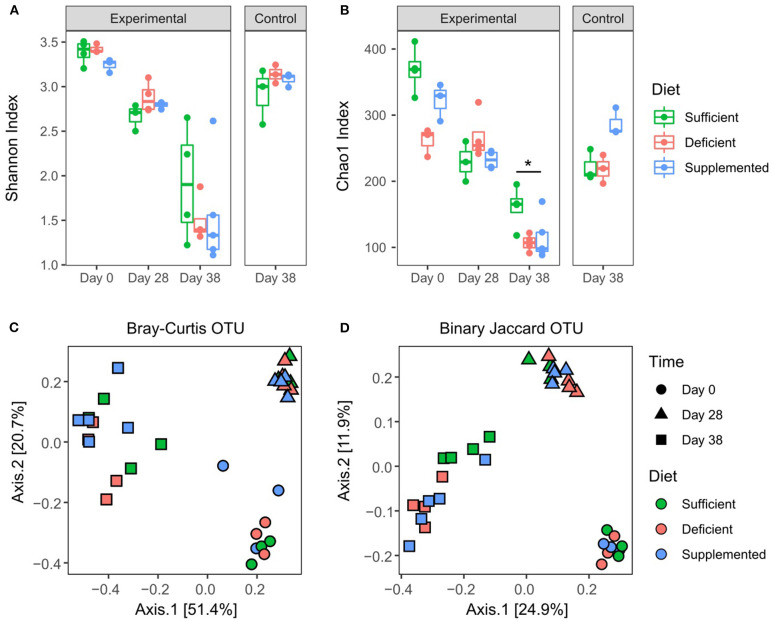
Effects of varying levels of dietary vitamin B12 on fecal microbial diversity and composition. Alpha diversity: Shannon index (A), OTU table rarefied 12,000. No significant differences between dietary groups post 4 weeks of intervention, or post DSS treatment. Chao1 index (B). Significant effects were found for both B12 diet (F2, 24 = 5.79, P = 0.009) and diet and time interaction (F4, 24 = 5.5, P = 0.002), Two-way ANOVA followed by Tukey's post-hoc test. Beta diversity: Binary Jaccard (C) and Bray-Curtis (D) were analyzed on OTU table rarefied to 12,000 reads. Significant differences were found within dietary intervention groups when comparing four weeks of dietary invention to baseline, however no differences between vitamin B12 diet intervention groups were identified at any time point. PERMANOVA P < 0.05, statistical singnicance represented as *p < 0.05.